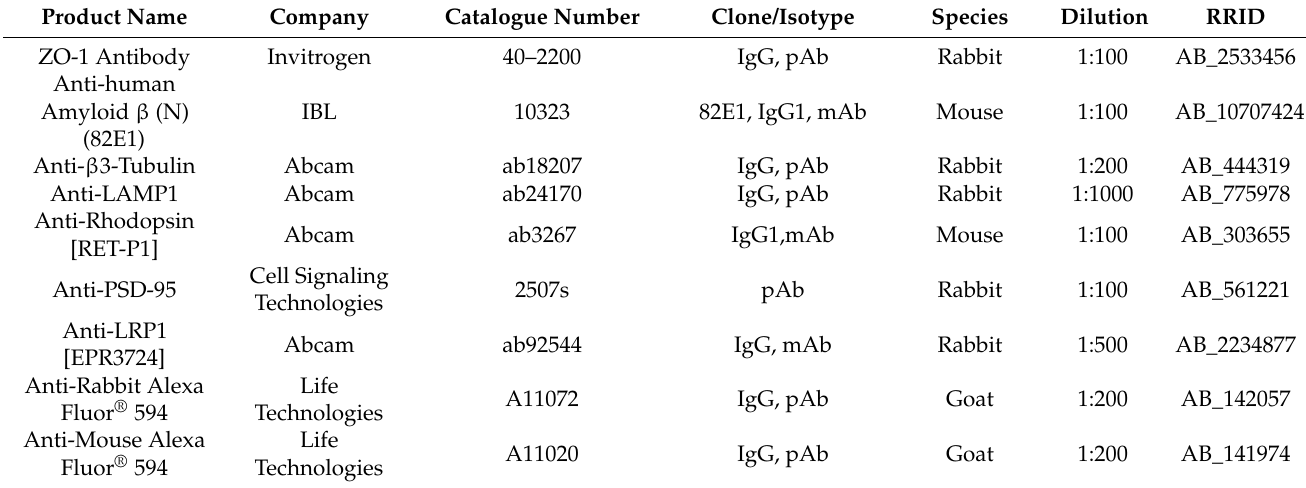
Table 1. Primary and secondary antibodies used for confocal immunofluorescence microscopy studies. Antibodies were diluted in blocking buffer to ratios indicated in the table. Ig: immunoglobulin; mAb: monoclonal antibody; pAb: polyclonal